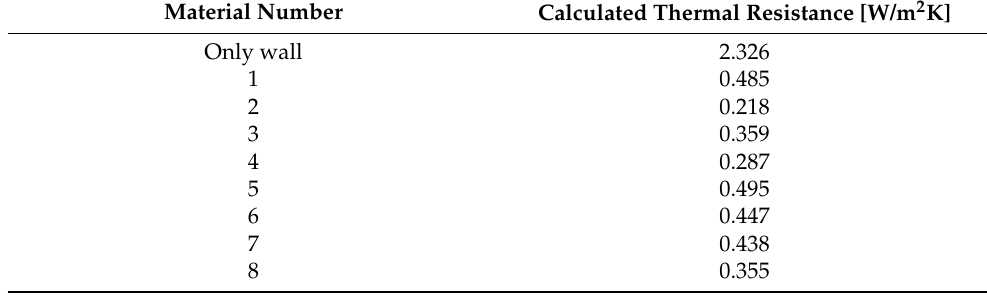
Figure A13. Wall type 5.1: stratigraphy with thicknesses and conductivities for the different layers. The numbers start from the outside. Table A7. Wall type 5.1: thermal transmittance reached with different heat-reflective materials.